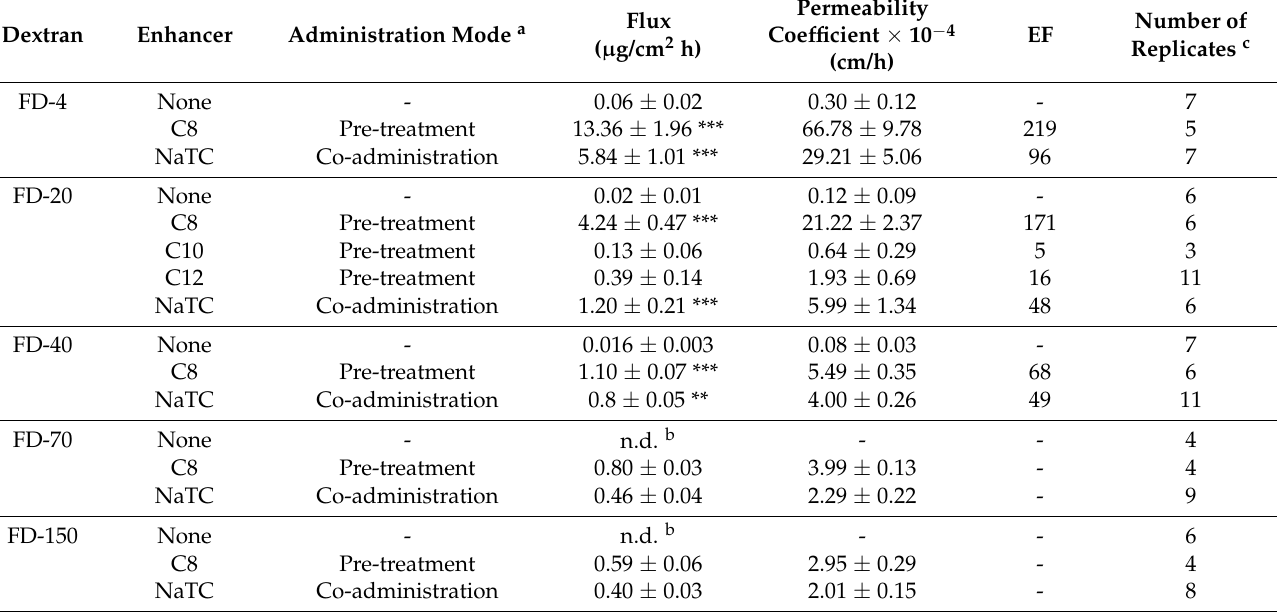
Table 1. Permeation parameters of dextran across the pig esophageal epithelium (mean values ± SEM) using fatty acids and bile salts as penetration enhancers.